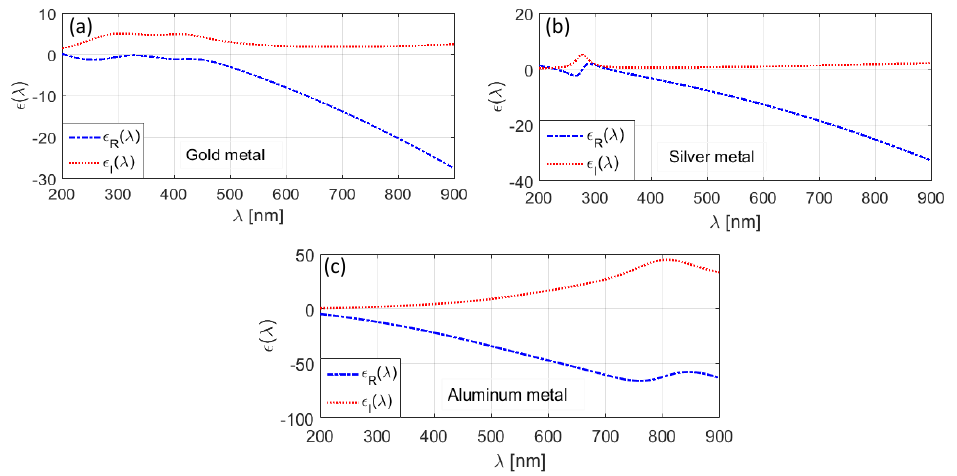
Figure 2. Wavelength-dependence of permittivity for ( a ) Au, ( b ) Ag, and ( c ) Al.